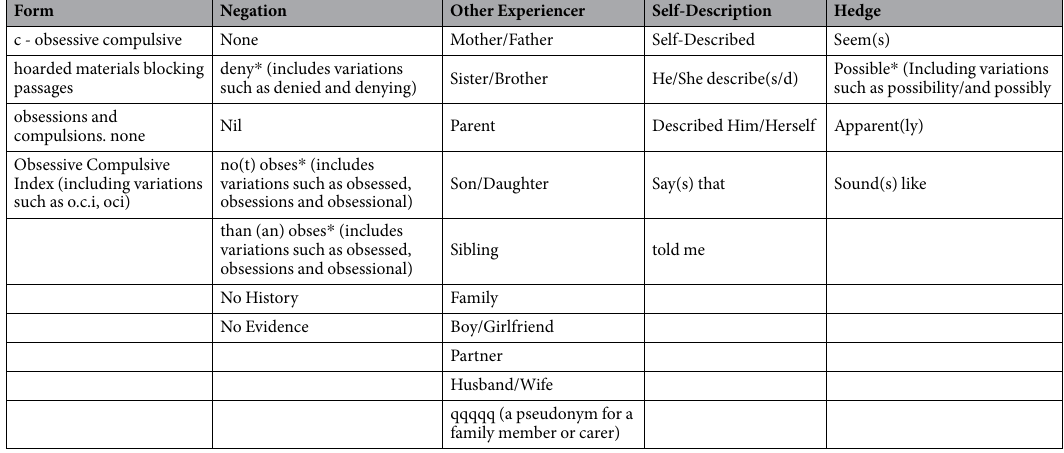
Table 2. List of terms used to identify candidates for